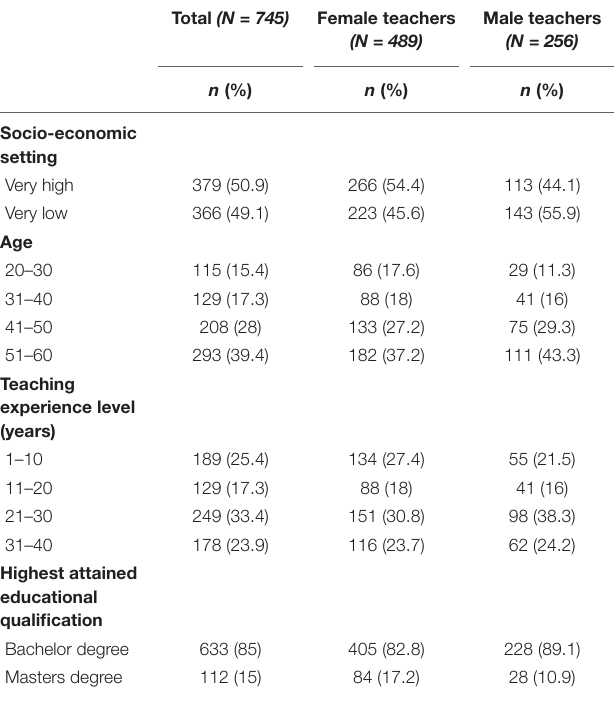
TABLE 1 | Demographic characteristics of the survey